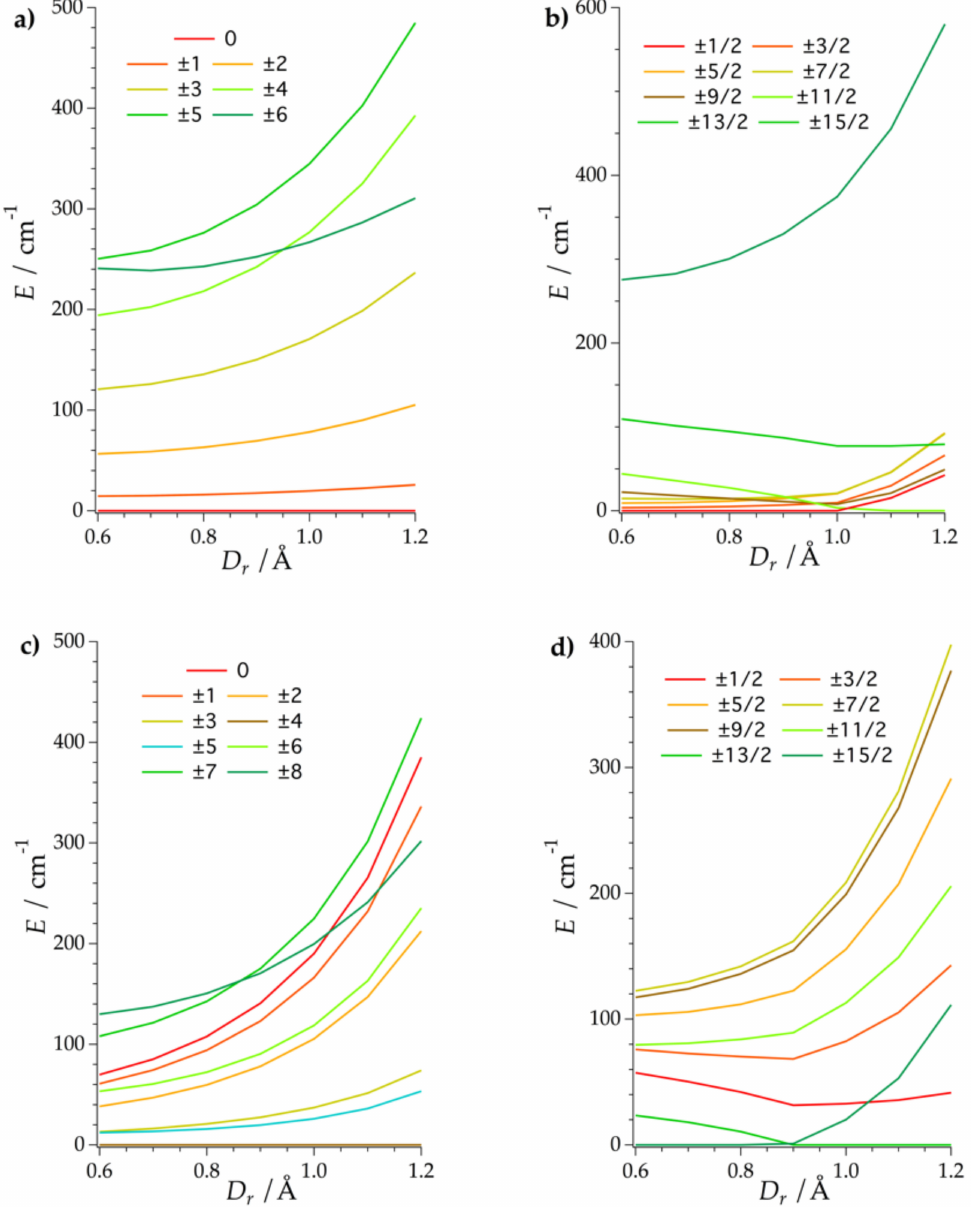
Figure 3. Energy level scheme of the ( a ) 1-Tb ; ( b ) 1-Dy ; ( c ) 1-Ho, and ( d ) 1-Er as a function of D r using the Radial Effective Charge (REC) model. The different colors indicate the main M J contribution to the wave